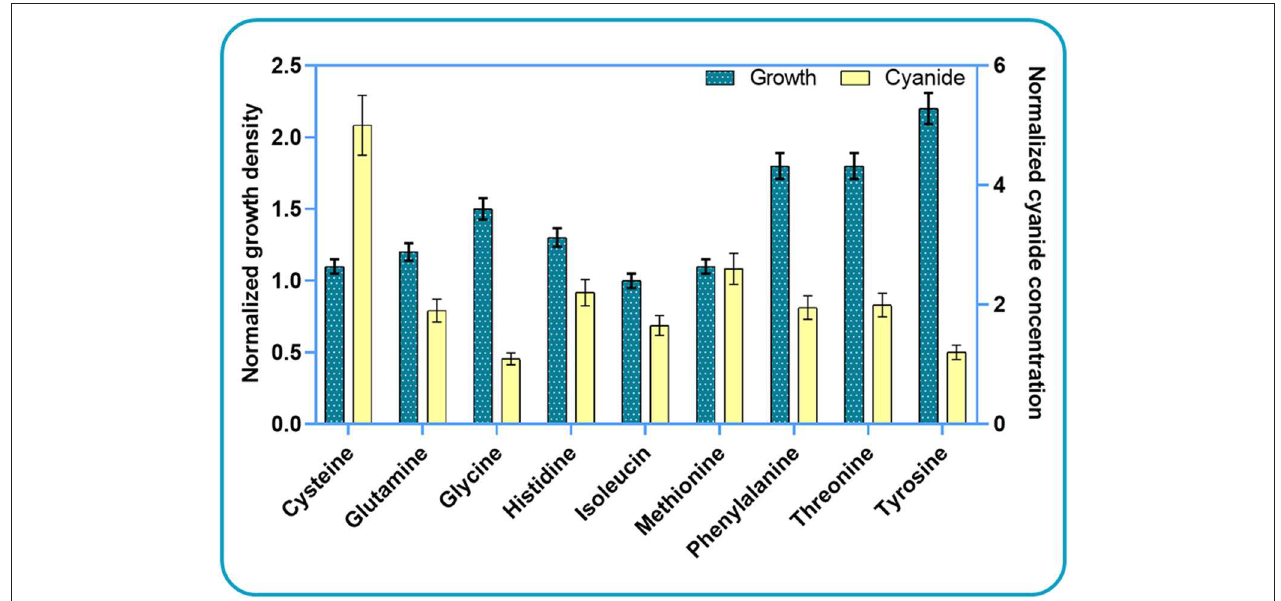
FIGURE 3 | Experimental results for studying the impacts of amino acid elimination on bacterial growth behavior and cyanide production. The growth and cyanide results are normalized with respect to the cell density and cyanide amounts achieved when CDM1 with no amino acid is used as the culture medium.